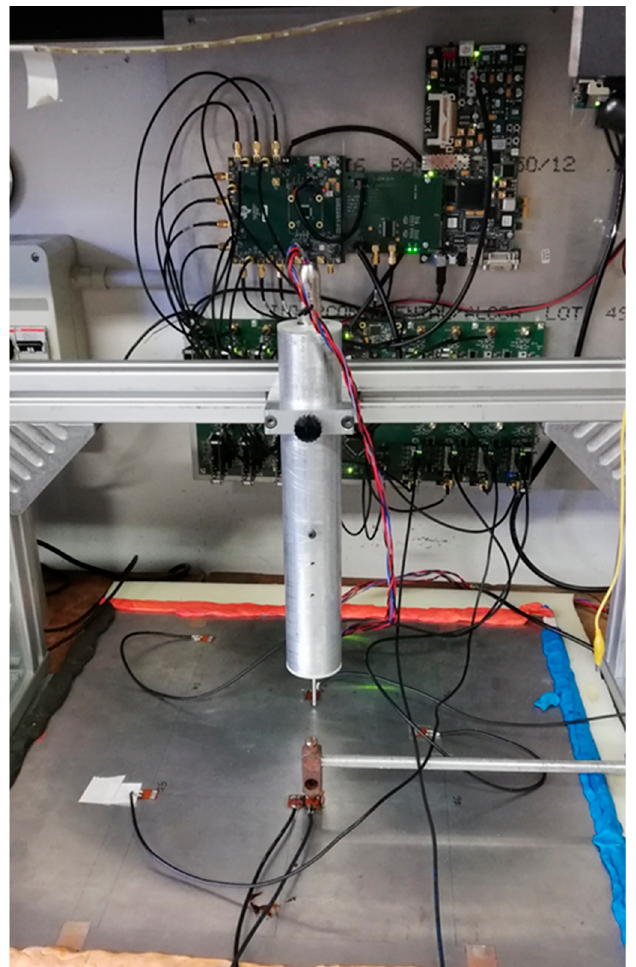
Figure 13. The experimental setup for impact continuous monitoring by a 16-module electronic platform. The picture shows the two impactors: the electromechanical programmable impactor with a thin steel bar integrated into the vertical cylindrical case (shown in the center), and a free-fall mass mounted on an arm with 1 angular degree of freedom (shown on the bottom-right).